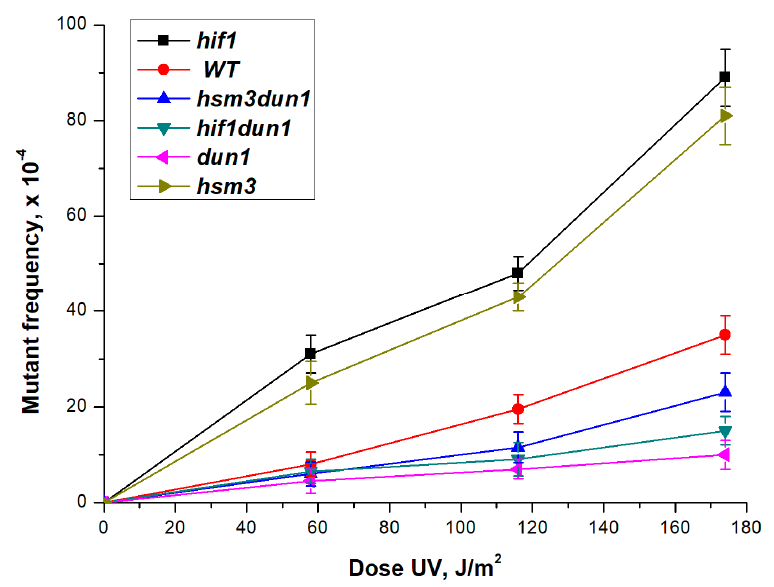
Figure 8. UV-induced mutagenesis in mutant strains hif1 ∆ (CAY-3 ), hsm3 ∆ dun1 ∆ (DVF-15) , hif1 ∆ dun1 ∆ (TAE-154 ), dun1 ∆ (DVF-16) , hsm3 ∆ (5-LGM-3031), and strain wild-type (LMG-3031) at different UV doses. The mutation frequencies were determined, as a ratio of the number of white colonies to the number of all colonies grown in a cup with complete medium. The mean ± SEM values obtained from four independent experiments are plotted.